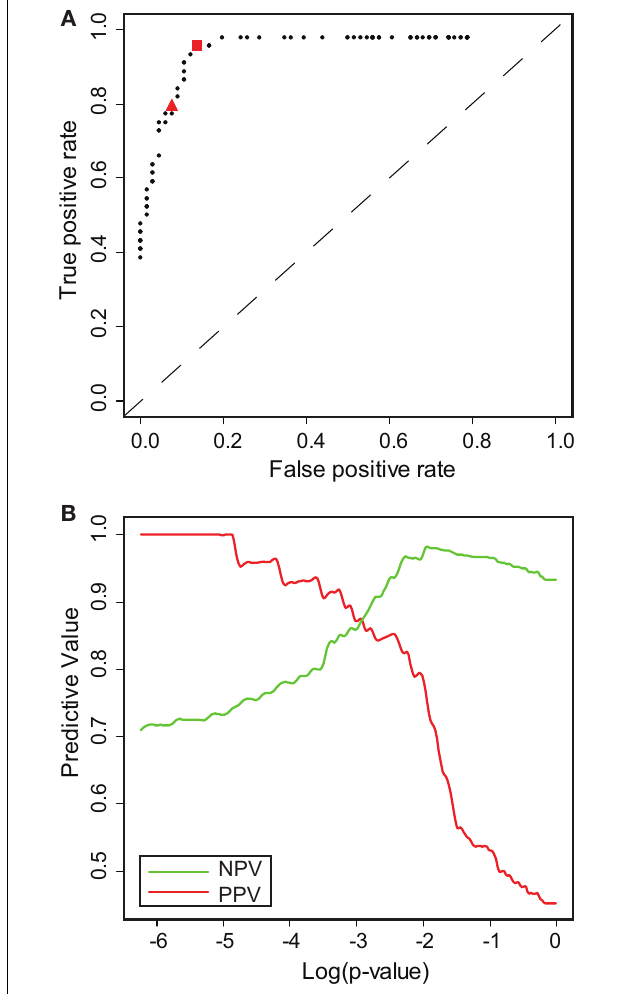
FIGURE 4 | ROC analysis of bisulfi te sequencing validation results. (A) ROC curve of True Positive Rate vs. False Positive Rate. Red square indicates p = 0.005; red triangle indicates p = 0.001. (B) Plot of Negative (green) and Positive (red) Predictive Value versus Log ( p -value). Intersection at 2 NPV = PPV = 87% and p =